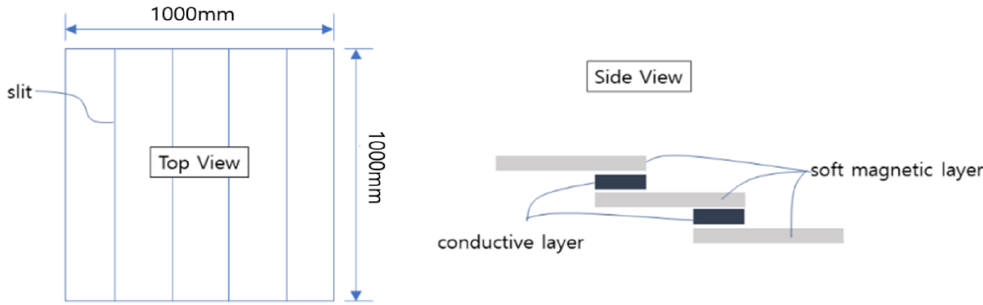
Figure 1. Top and side views of the amorphous soft magnetic composite specimen.